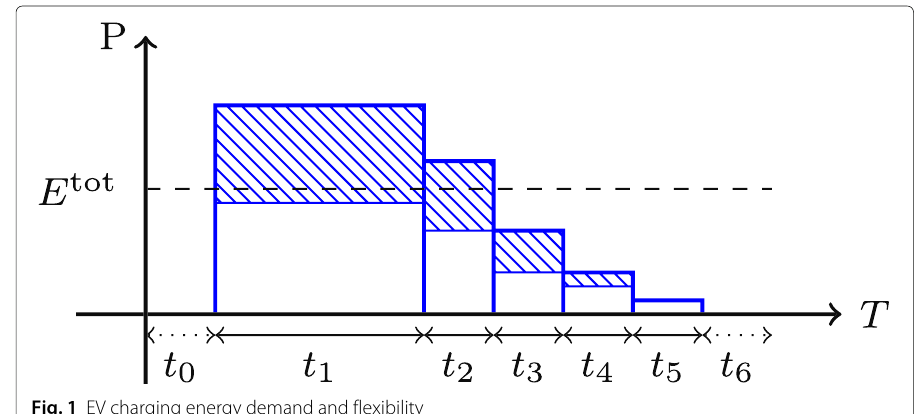
Fig. 1 EV charging energy demand and